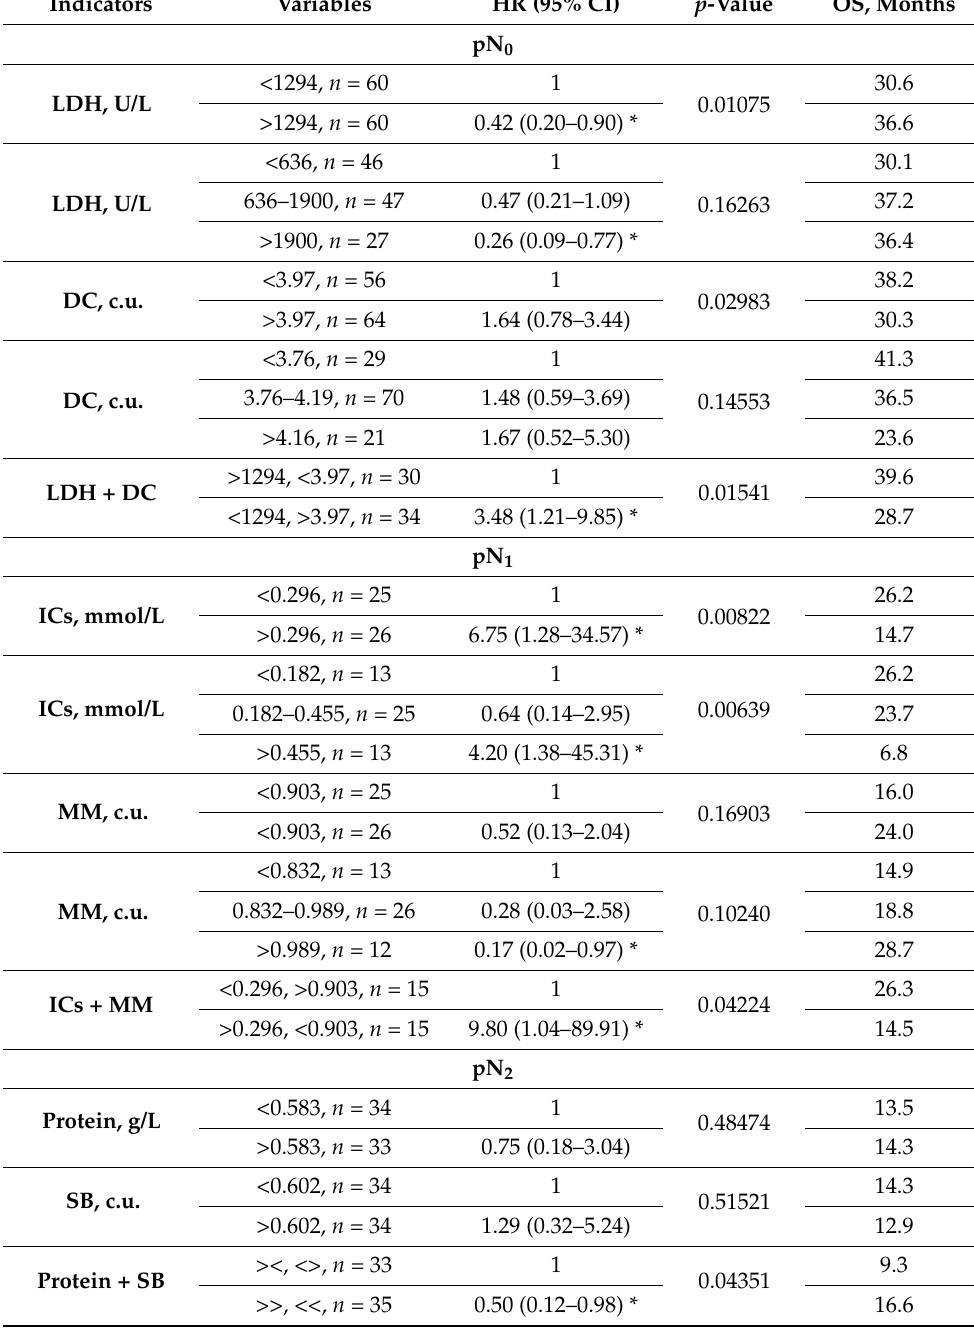
Table 3. Prognostic value of saliva biochemical markers depending on the prevalence of metastases in the lymph